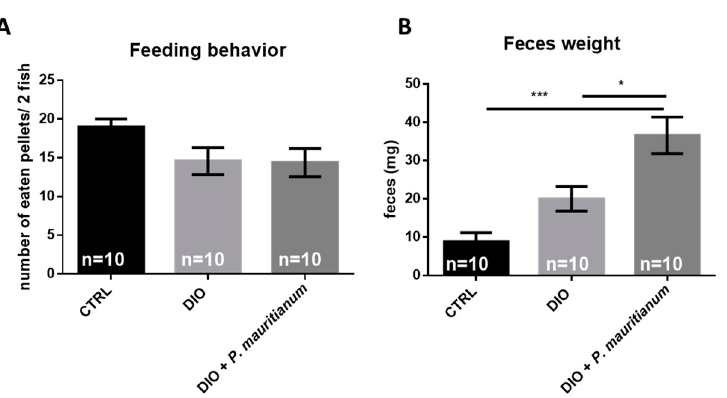
Figure 9. P. mauritianum does not impact feeding behavior and favors feces excretion. ( A ) Graph showing the number of pellets consumed by fish for 5 days in CTRL, DIO and DIO treated with P. mauritianum groups. ( B ) Quantification of the feces weight excreted by the fish for 5 days in the CTRL, DIO and DIO treated with P. mauritianum groups. n = 10, number of zebrafish used in the experiment for 5 days (2 fish/tank/day). The feeding behavior in ( A ) was assessed for fish each day, and in ( B ) the feces excretion was measured for 10 fish. Bar graph: standard error of the mean (SEM). One-way ANOVA: * p < 0.05; *** p < 0.001.